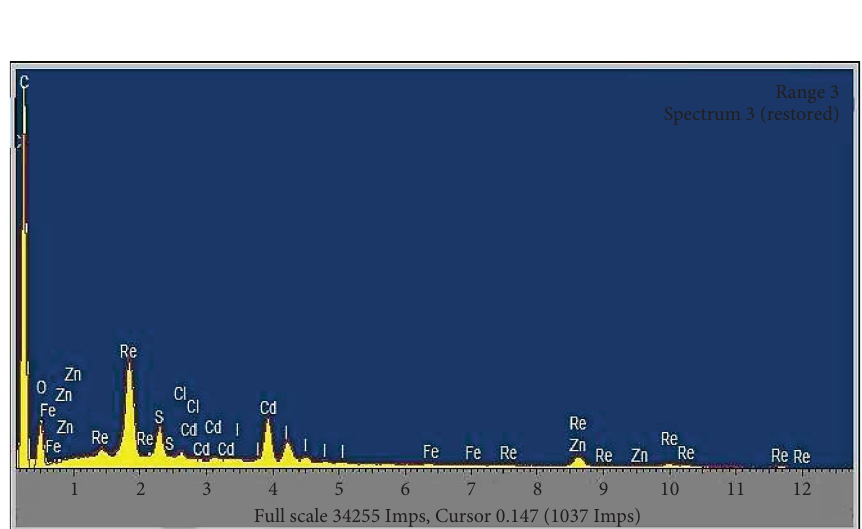
Figure 7: Spectrum of saturated